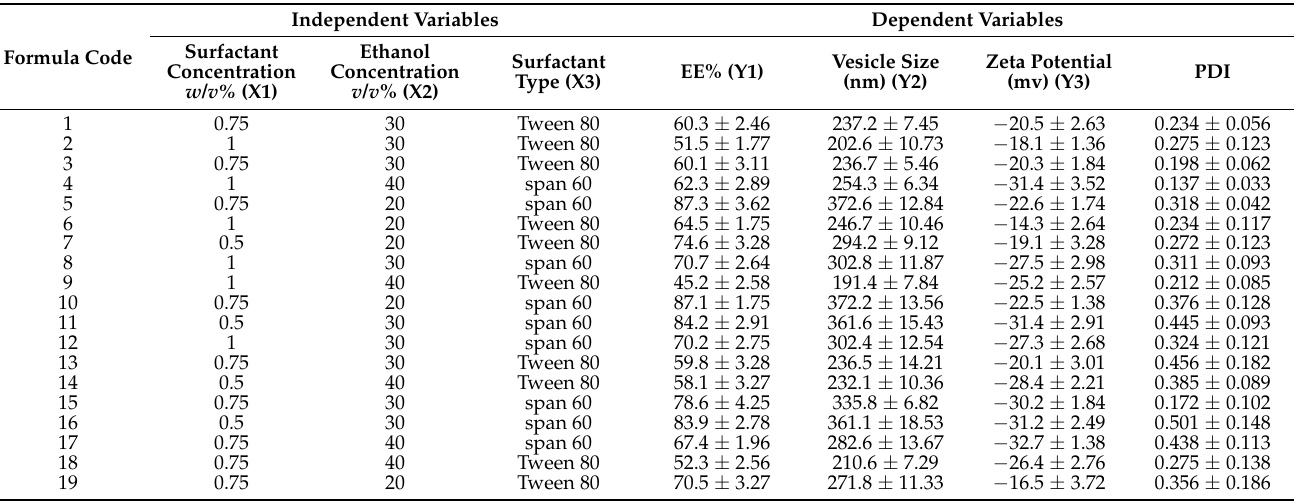
Table 2. Composition of different formulations with their responses in I optimal design for optimiza- tion of ROS-loaded